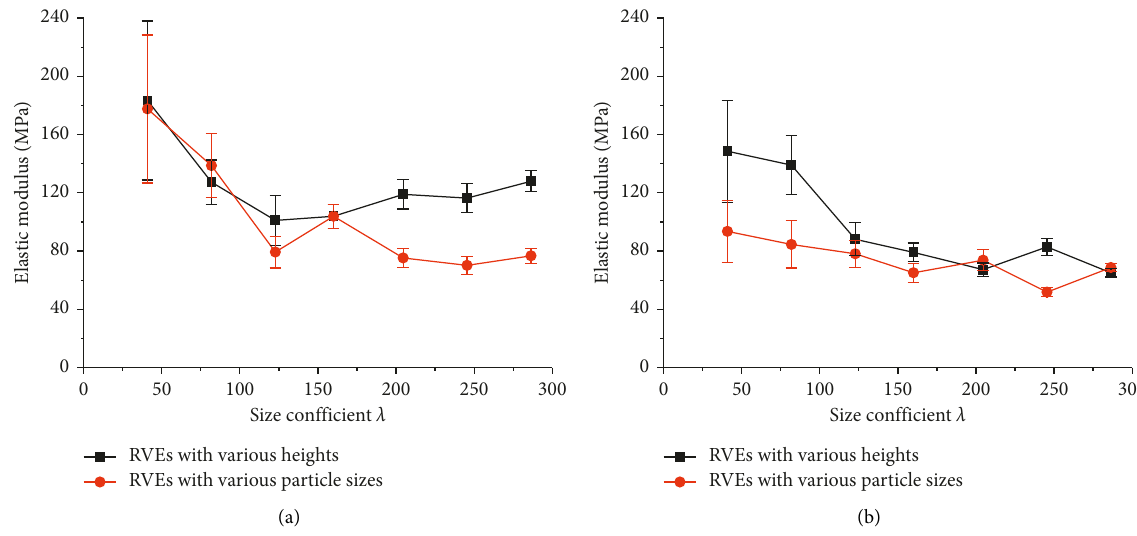
Figure 8: Elastic modulus-size coefficient relationship of RVEs with various heights and particle sizes. (a) At 0g gravity. (b) At 5g